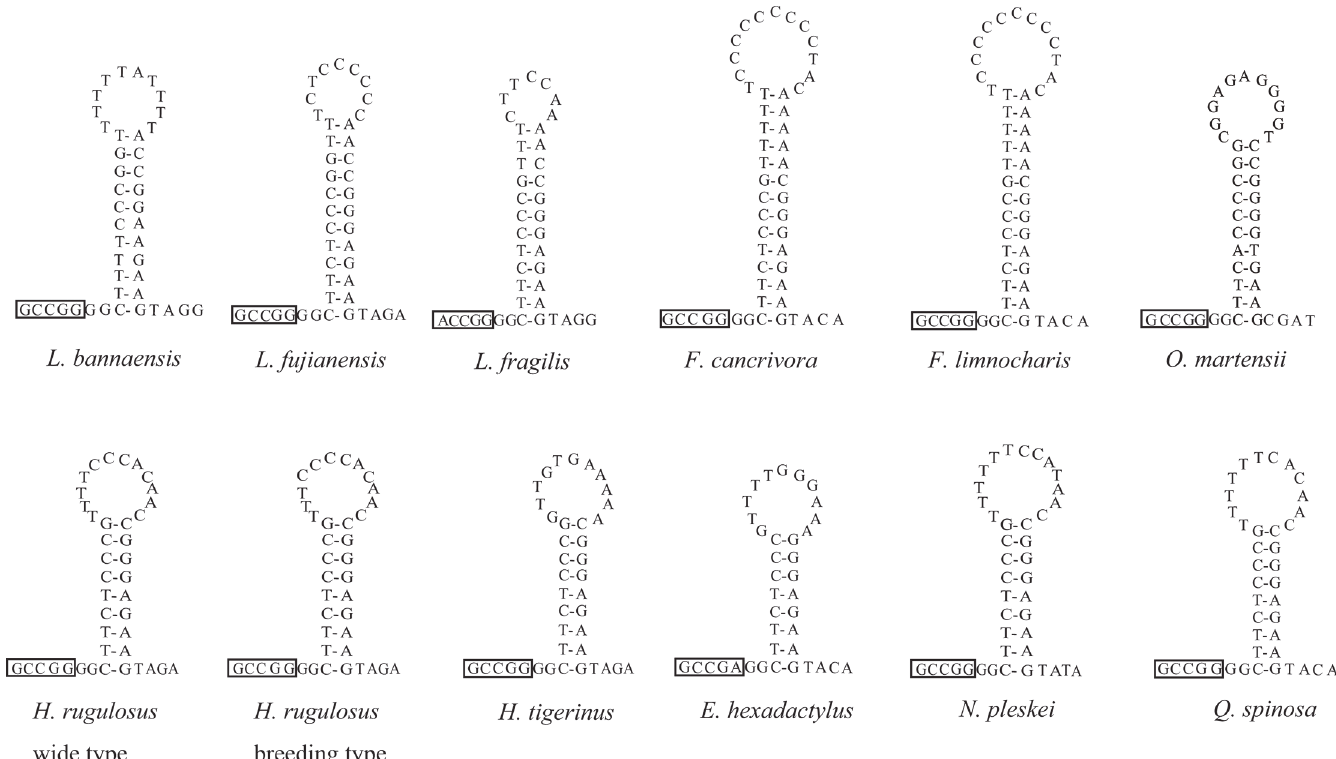
Fig 3. Putative secondary structures of O L of 12 species of Dicroglossidae. Dashes ( – ) indicate Watson – Crick base pairing.